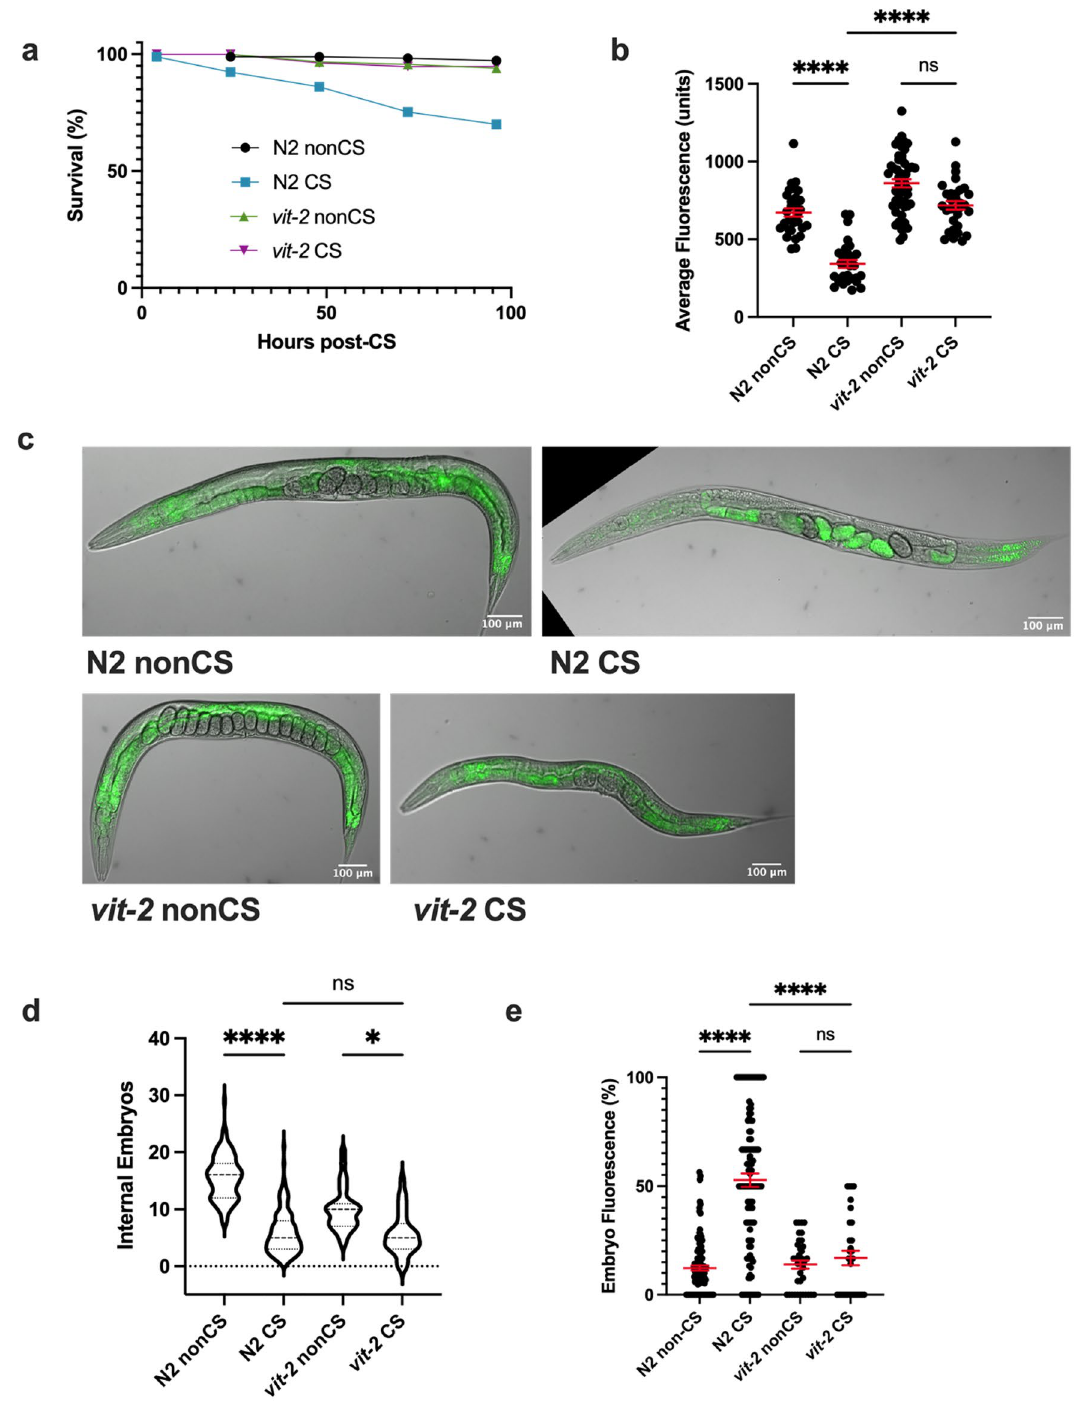
Figure 5. VIT-2-regulated vitellogenesis during recovery promotes lipid relocalization and impairs survival. ( a ) vit-2(ok3211) loss-of-function mutants were cold shocked and recovered while monitoring survival rates (n ≥ 130 worms per condition). ( b ) At 12 h post-CS or nonCS, vit-2(ok3211) were Nile Red lipid-stained and average fluorescence per worm quantified (n ≥ 31 worms per condition; Kruskal–Wallis test: H = 75.18, P < 0.0001; Dunn’s Multiple Comparison test: ****P < 0.0001). Error bars are mean ± s.e.m. ( c ) Images of Nile Red Staining show intestinal lipid retention in vit-2 mutants. ( d ) Number of embryos (Kruskal–Wallis test: H = 169.9, P < 0.0001; Dunn’s Multiple Comparison test: * P = 0.0149, **** P < 0.0001) and ( e ) percent of fluorescent internal embryos (Kruskal–Wallis test: H = 101.5, P < 0.0001; Dunn’s Multiple Comparison test: **** P < 0.0001) were quantified per worm from Nile Red images (n ≥ 31 for b – e ; error bars are mean ±